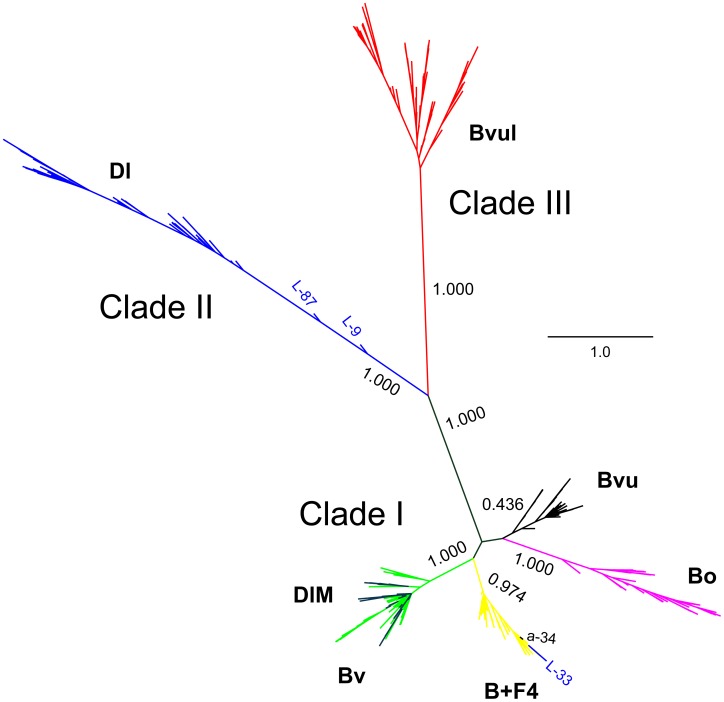
Phylogenetic relationship among different satBaMV populations.Unrooted Bayesian tree was constructed with full-length satBaMV genomic sequences. For clarity of presentation, sequence names are not shown, except for the listed (see text for details). Yellow, B+F4; magenta, Bo; green, Bv; black, Bvu; red, BvuI; blue, Dl; purple, DlM. Posterior probabilities are shown for major branches.